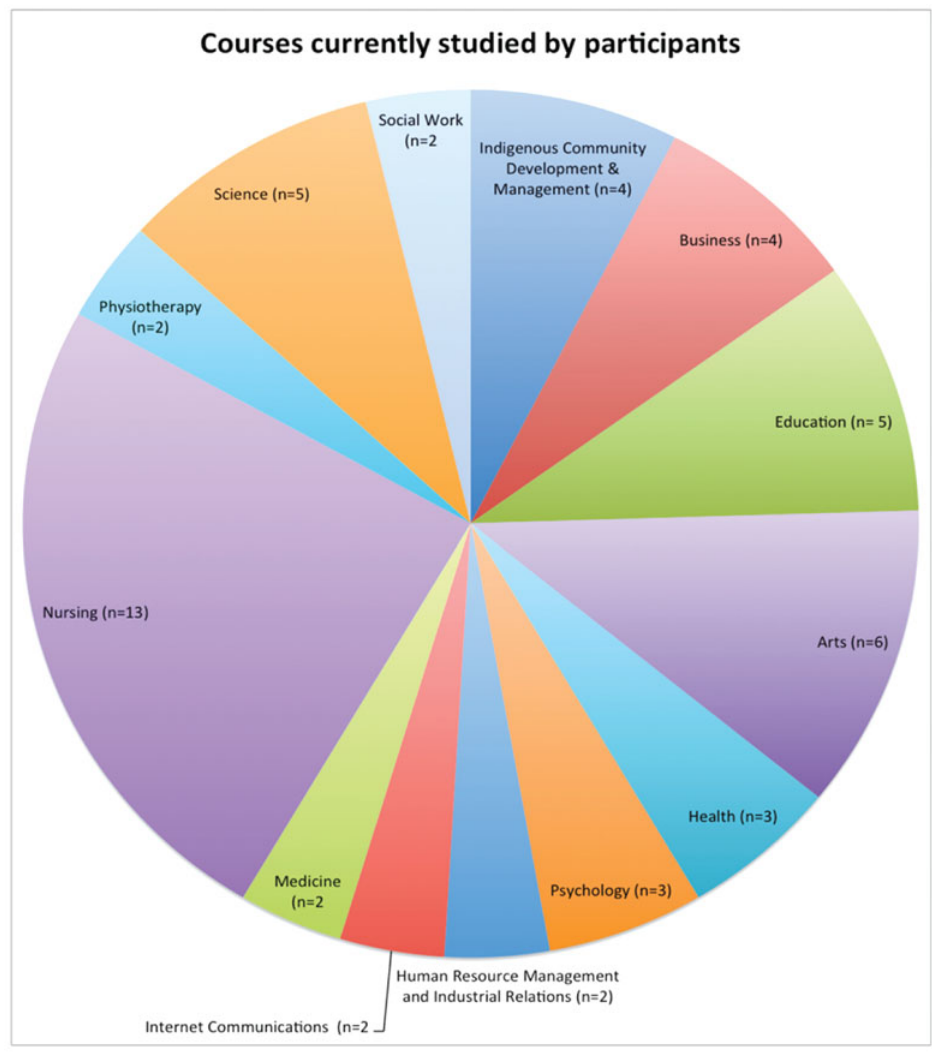
(Colour online) Percentage enrolment areas of survey